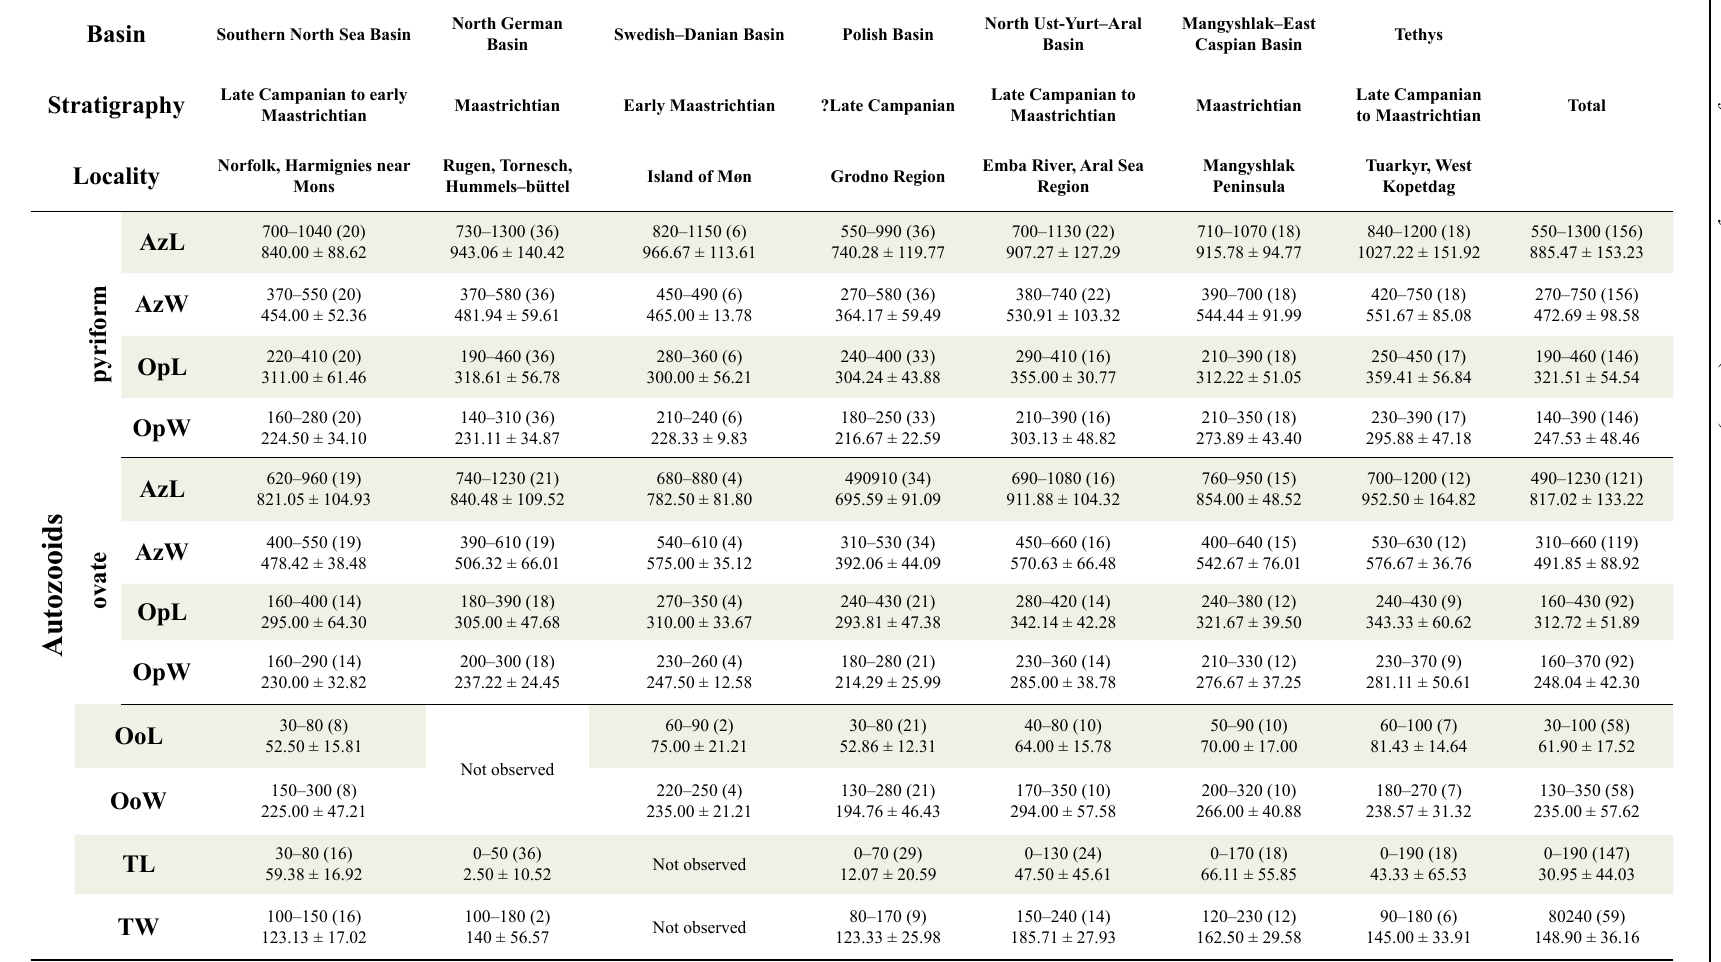
Table 10 (continued on next page). Summary of measurements of Rhagasostoma rowei (Brydone, 1906). For each parameter the range is given with the number of measurements in brackets. The arithmetic mean is given ± standard deviation. All measurements in